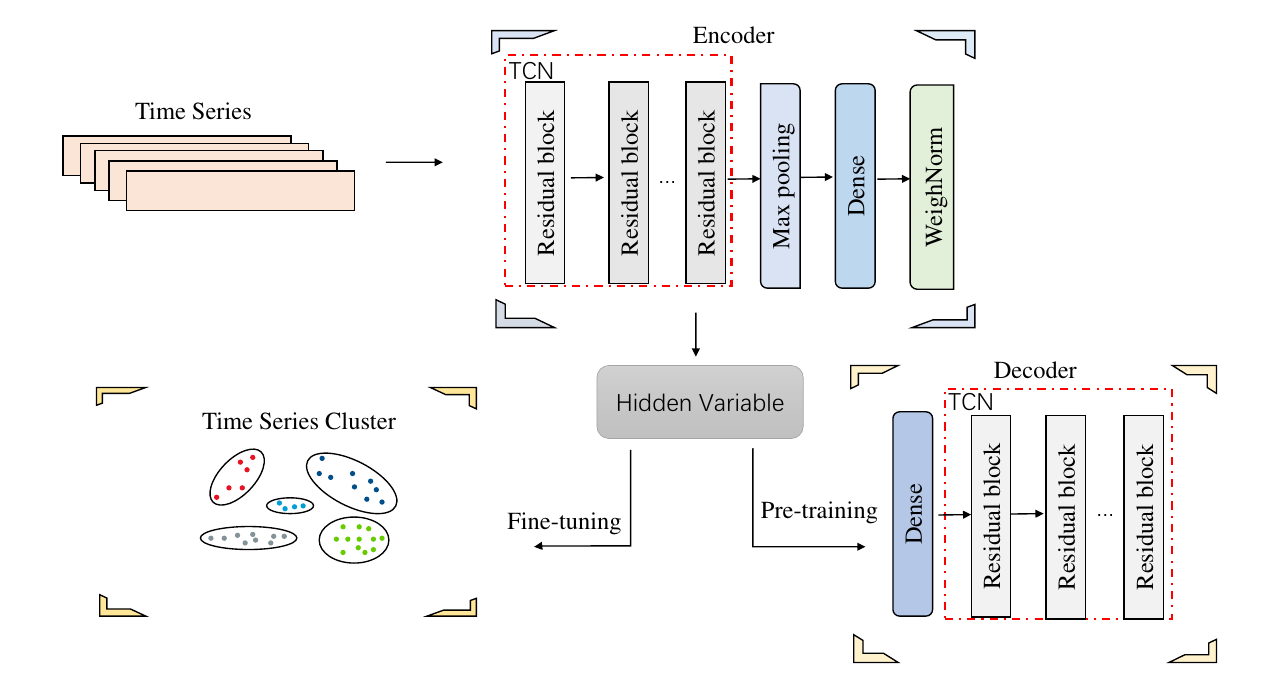
Figure 1. Architecture of TCN-Deep